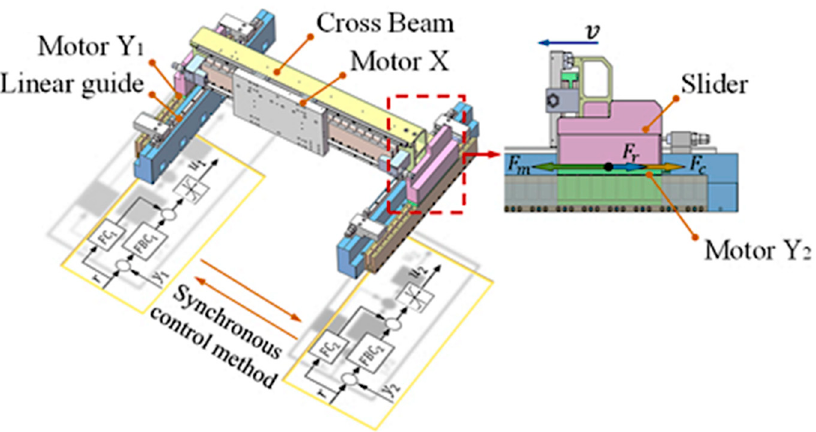
Figure 1. Schematic of the structure and control strategy of redundant direct-drive gantry plat- form.